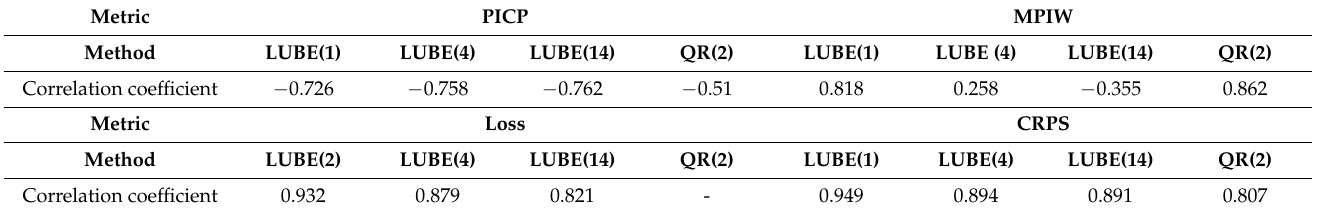
Table 9. Correlation coefficient with 30-min output fluctuation for LUBE (1), (4), (14), and QR